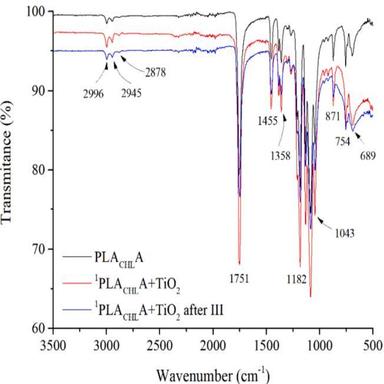
FTIR spectra of PLACHLA, 1 PLACHLA + TiO2, and 1 PLACHLA + TiO2 after three cycles of illumination.